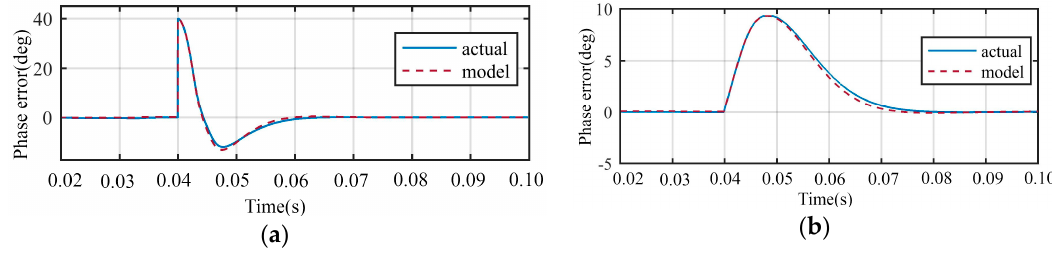
Figure 15. Performance comparison between proposed-PLL and its small-signal model under ( a ) a phase jump of +10°, and ( b ) a frequency jump of +1 Hz.